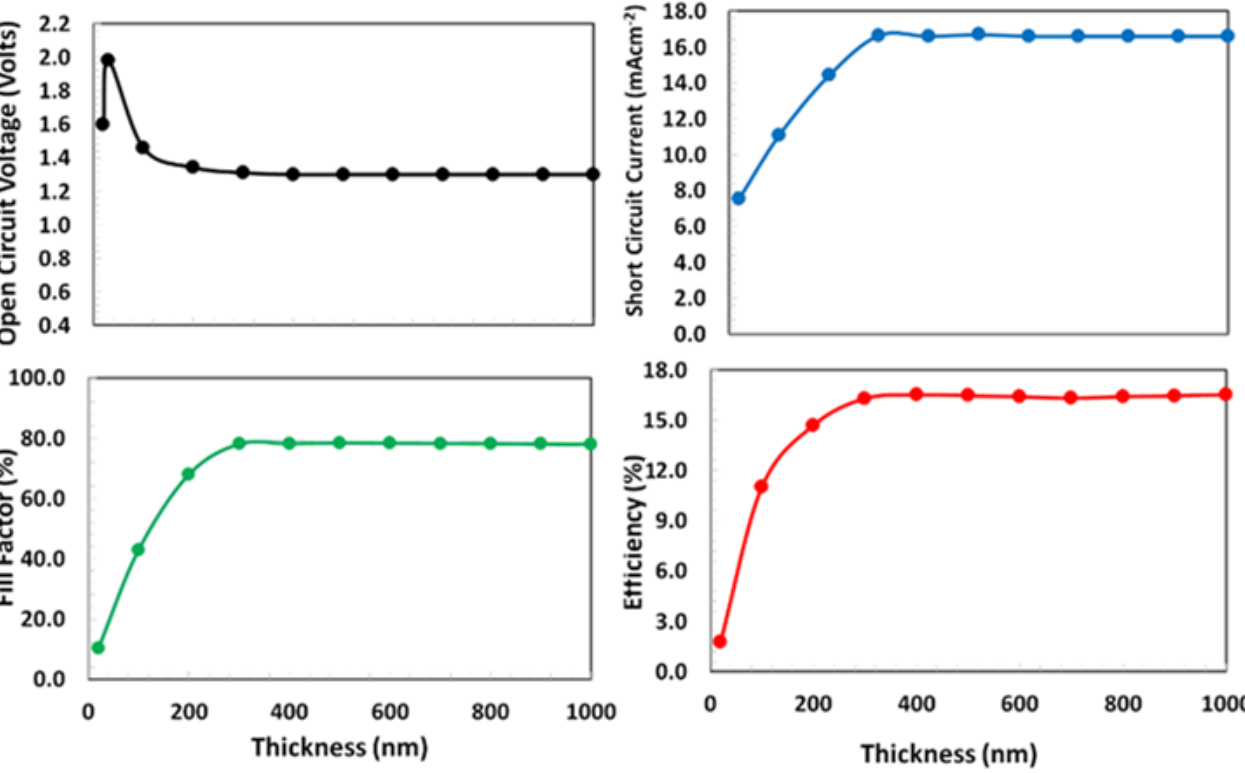
Figure 4. ( a ) Open-circuit voltage, ( b ) short-circuit current, ( c ) fill-factor, and ( d ) power-conversion efficiency of proposed solar cell Ag/BCP/PCBM/Cs 2 TiBr 6 /NPB/ITO as a function of Cs 2 TiBr 6 thickness from 10 to 1000